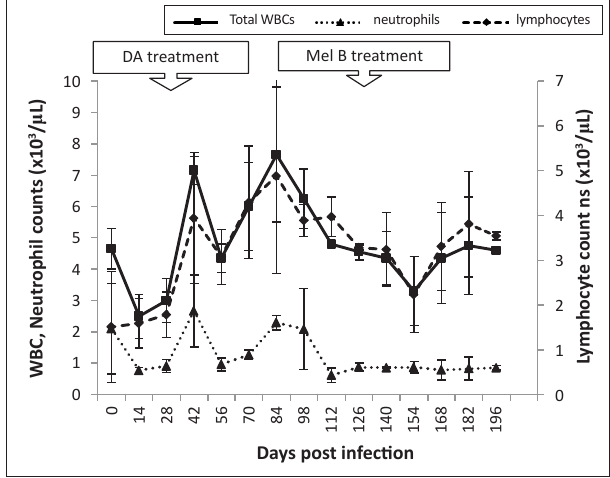
FIGURE 7: Mean changes in total white blood cells (WBC), lymphocyte and neutrophil counts of T. b. brucei GUTat 1-infected vervet monkeys showing the point of subcurative treatment with diminazene aceturate (DA) (28 dpi) and curative treatment with melarsoprol (Mel B) (119 dpi).